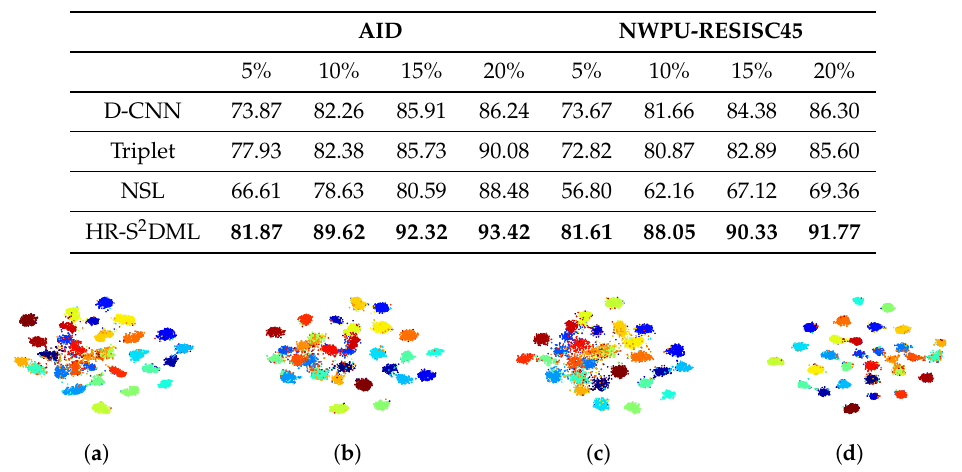
Figure 4. 2-D projection of the generated feature embeddings on the AID test set using t-SNE based on the considered methods, when the percentage of the labeled images is 20%. ( a ) D-CNN. ( b ) Triplet. ( c ) NSL. ( d ) HR-S 2 DML.